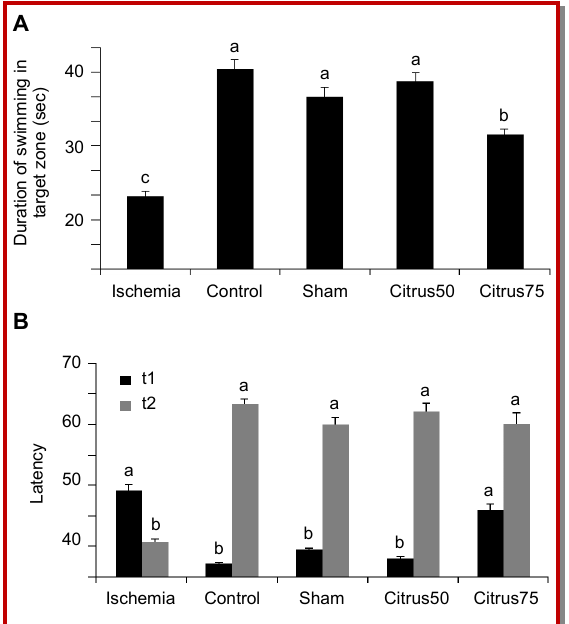
Figure 3: Comparison of the probe day, duration of swim- ming in target zone (A); Comparison of primary and secondary latency (B) in different groups. Similar letters represent no significant difference and dissimilar letters represent significant difference (p<0.05) (Citrus75 and Cit- rus50: treated with 75 and 50 mg/kg of C. aurantium essen- tial oil, respectively)